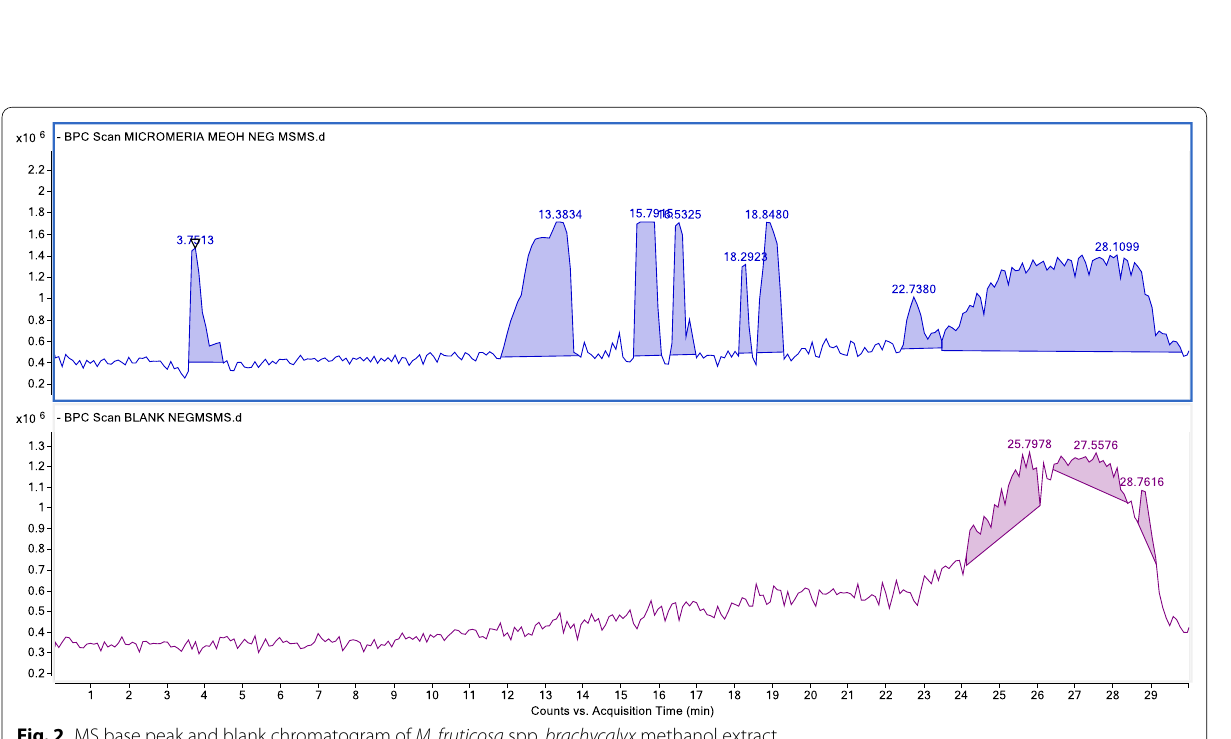
Fig. 2 MS base peak and blank chromatogram of M. fruticosa spp. brachycalyx methanol